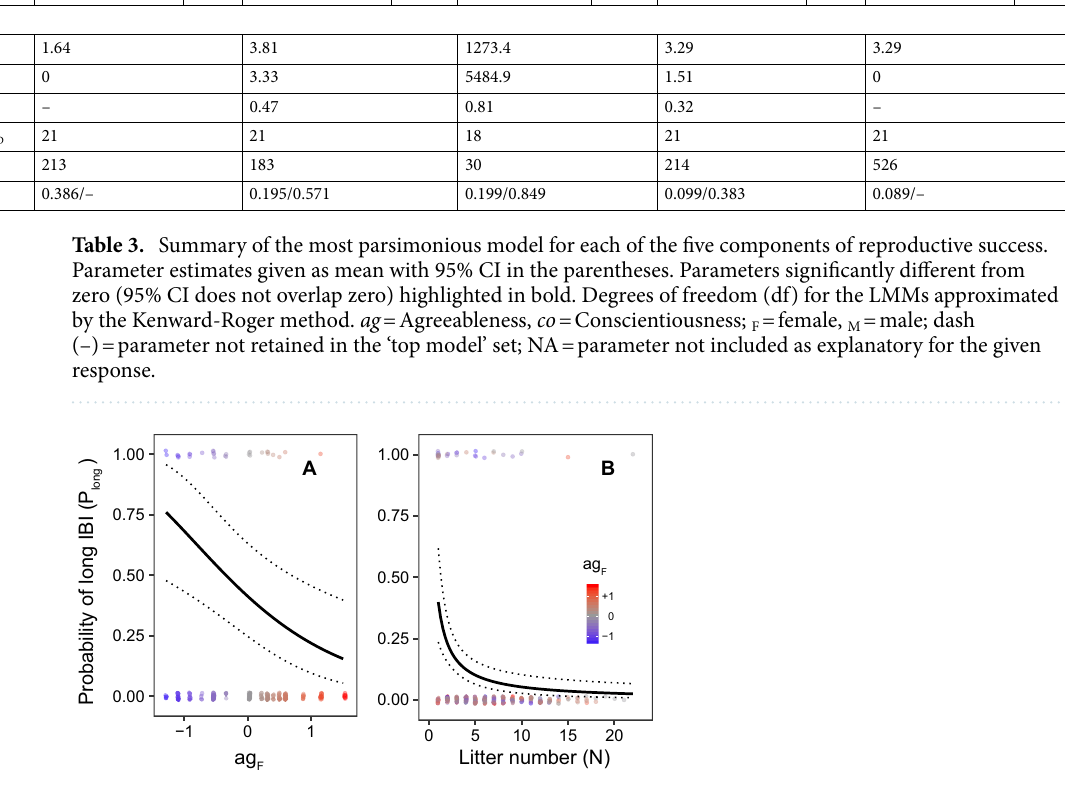
Figure 1. Effect plots for the most parsimonious model (lines: mean prediction ± 95% CI) linking the dependence of the probability of long IBI P long to ( A ) female Agreeableness z -score ag F and ( B ) pair’s reproductive history defined as the sequential number N of the litter produced by the pair. Non-focal variable fixed at the first litter ( A ) or at the mean ag F value in the dataset ( B ); points = individual observations coloured by ag F